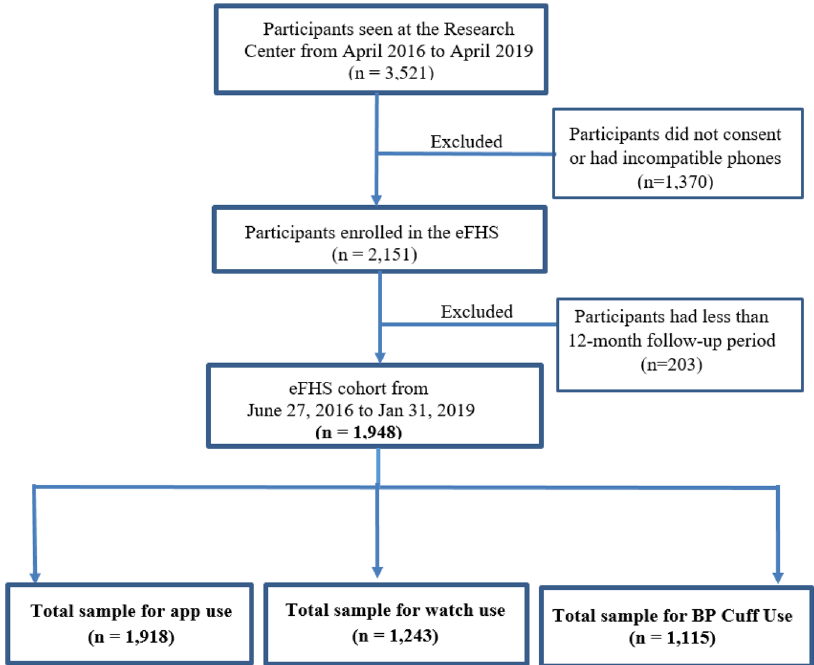
Fig. 1 Sample Selection for Analysis of eFHS System Components. In the eFHS cohort ( n = 1948), 30 participants took more than 90 days to return baseline surveys and were excluded as it was dif fi cult to distinguish baseline and follow-up surveys. The total sample for app use ( n = 1918) includes participants who didn ’ t return surveys ( n = 213) and who returned surveys ( n = 1705). The sample for watch use ( n = 1243) consists of participants who sent data from the watch ( n = 1185) and who took the watch but never sent any data ( n = 58). The total sample of BP cuff use includes participants who returned BP ( n = 969) data and who took the BP cuff but never sent any BP data ( n =